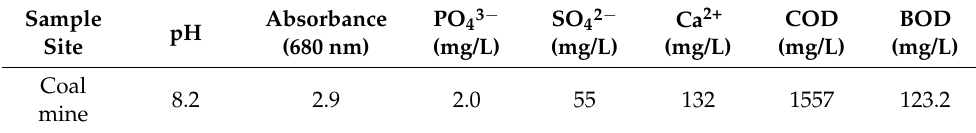
Table 1. Summary of physicochemical characteristics (mg/L) in the coal mine wastewater.